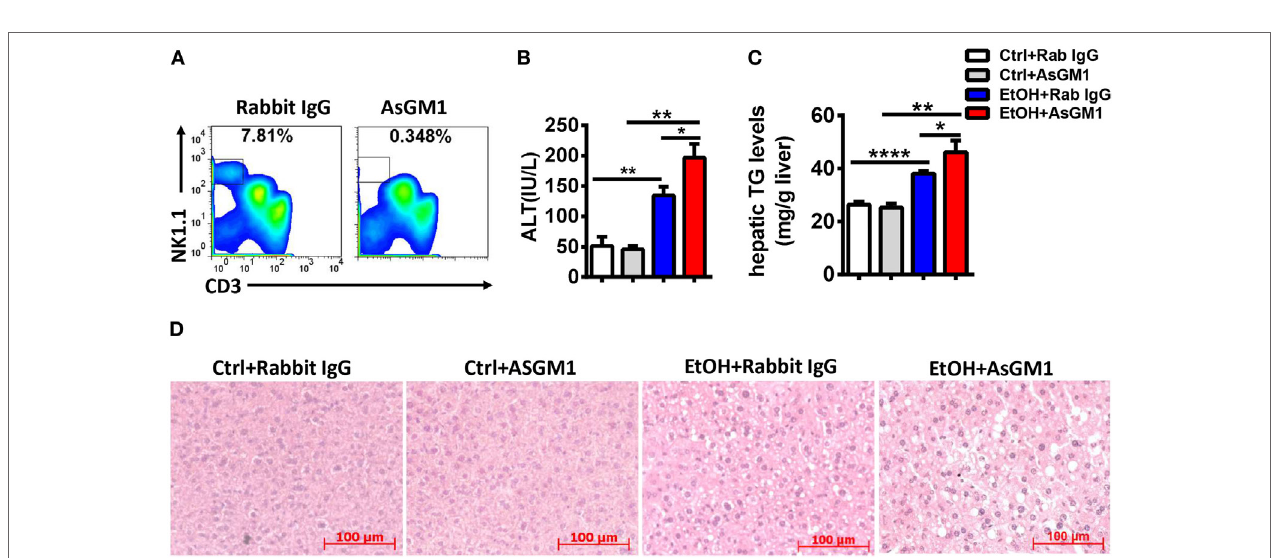
FigUre 8 | Natural killer (NK) cell deficiency promoted alcoholic hepatosteatosis in J α 18 − / − mice. Pair- or ethanol-fed J α 18 − / − mice were treated with anti-asialo GM1 or control rabbit IgG once every 3 days as described in Section “Materials and Methods” to deplete NK cells. The mice were euthanized 9 h after gavage. (a) Liver mononuclear cells were isolated, and the depletion efficiency was verified by flow cytometry; (B–D) liver injury and steatosis were evaluated by measuring (B) serum alanine aminotransferase and (c) hepatic triglyceride levels and (D) liver tissue by hematoxylin and eosin staining (original magnification, 200 × ). The data are representative of two independent experiments and are shown as the mean ± SEM ( n = 3–6). * P < 0.05; ** P < 0.01; **** P <